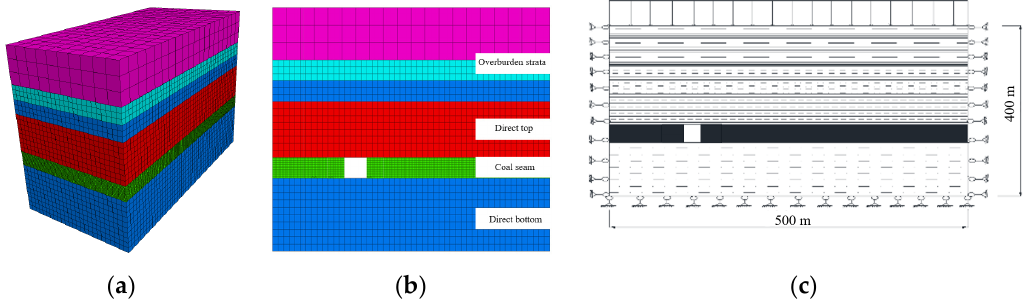
Figure 14. Stope model: ( a ) three-dimensional model grid diagram; ( b ) model profile; ( c ) stope geometric model.